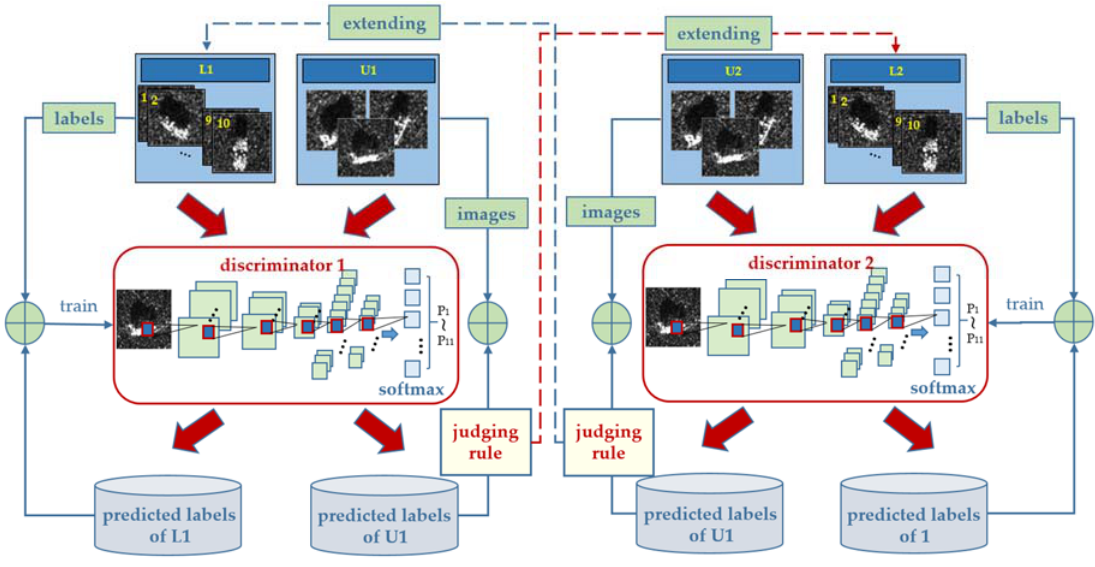
Figure 2. The process of joint training.